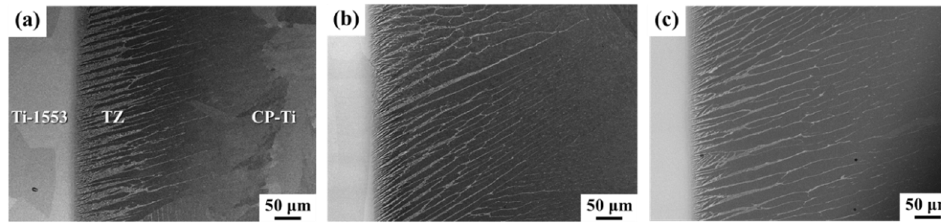
Figure 2. SEM-BEI (back-scattered electron image) photos of Ti-1553/Ti–15Cu–15Ni/CP-Ti brazed at 1243 K for ( a ) 3 min, ( b ) 30 min, and ( c ) 60 min.